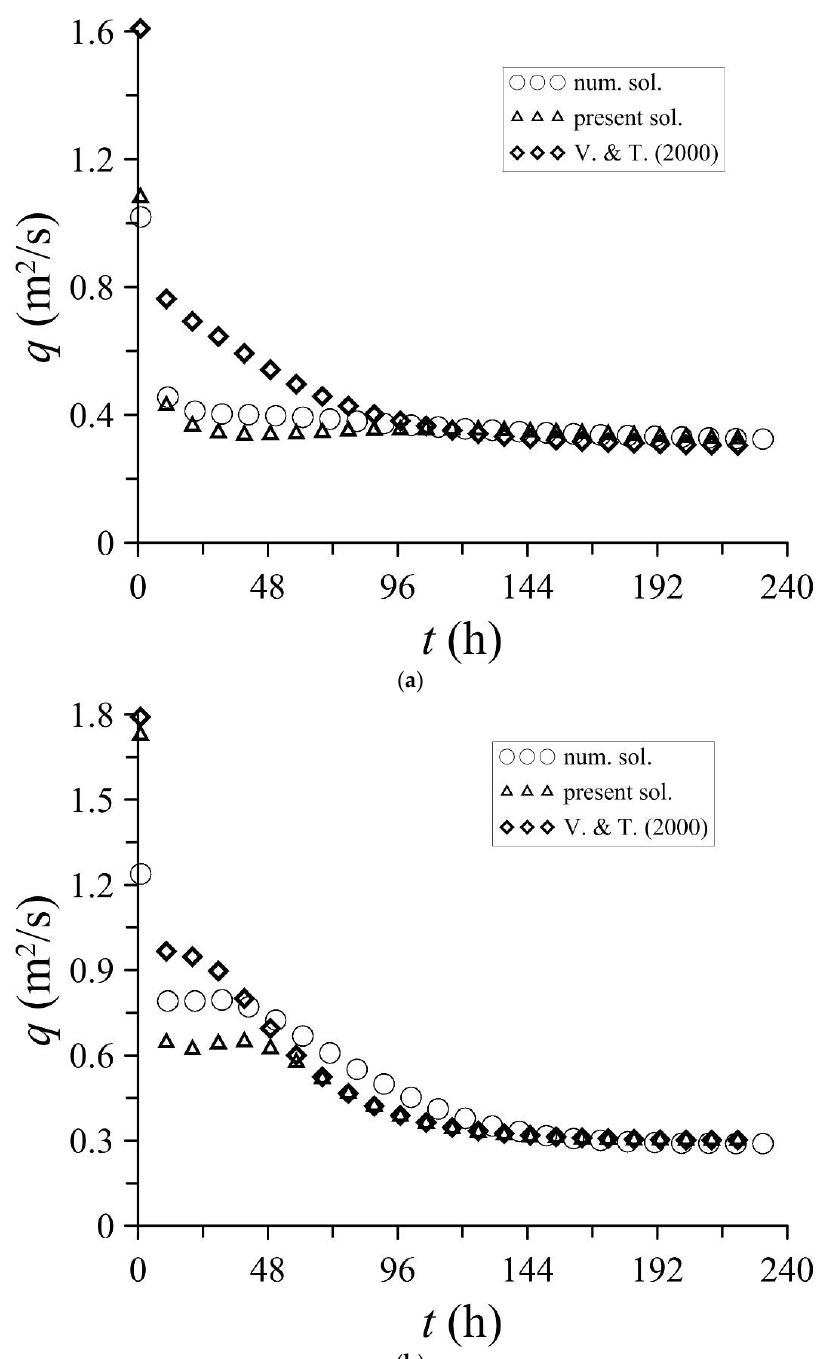
Figure 8. Transient variation of outflow under constant recharge for ( a ) 𝜃 = 2° ( b ) 𝜃 = 6° .